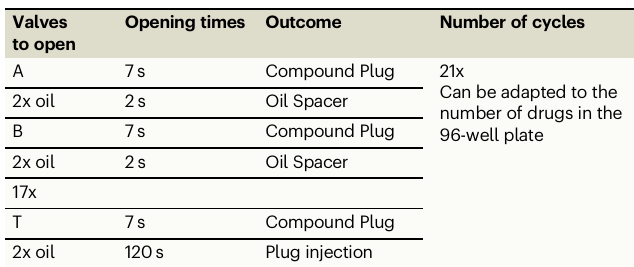
Table 3 | Braille valve